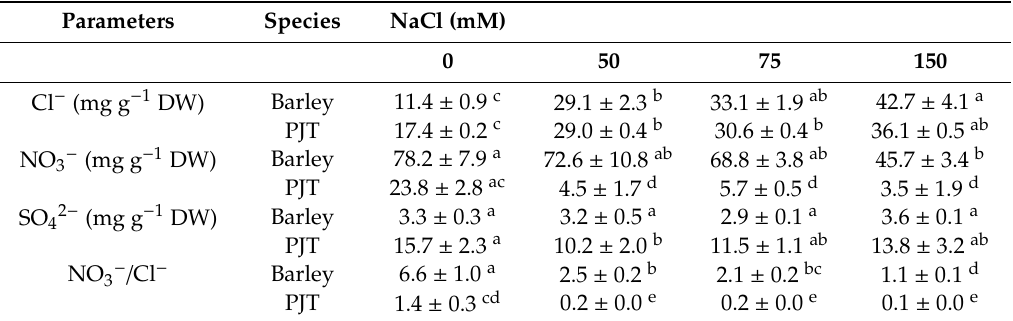
Table 3. Anion concentrations and NO 3 − / Cl − ratios in barley and Peucedanum japonicum (PJT) leaves at di ff erent NaCl concentrations.